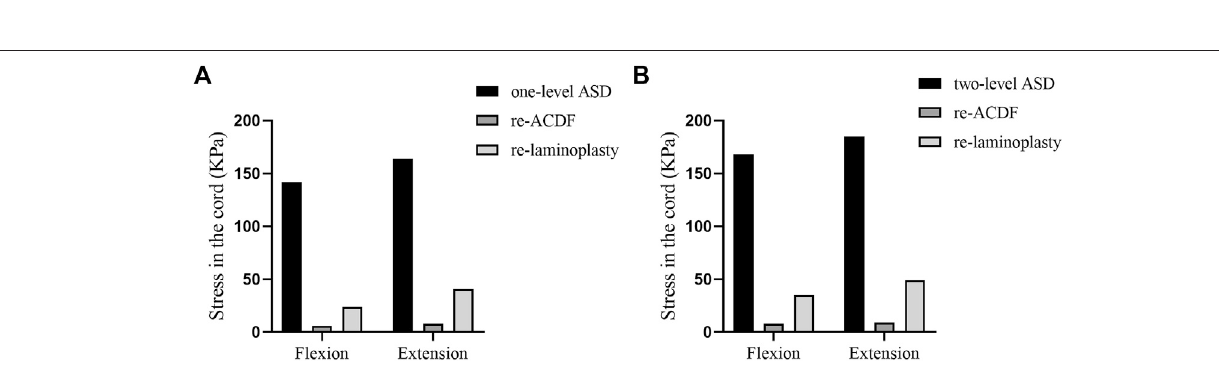
Frontiers in Bioengineering and Biotechnology |